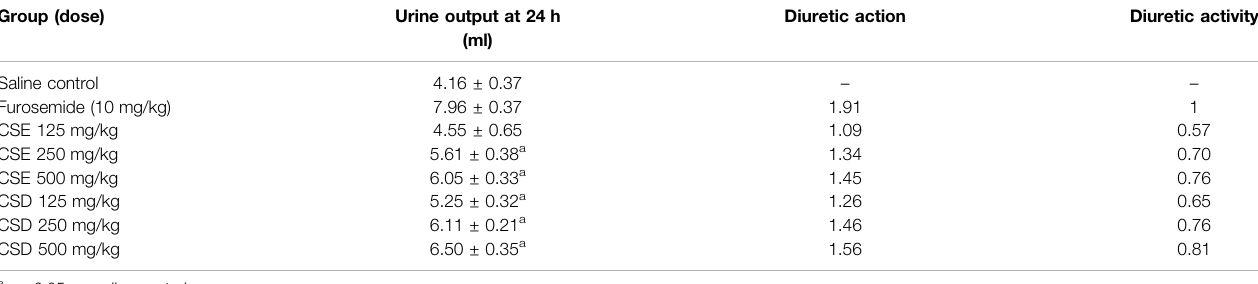
TABLE 4| Parametersofthediureticeffectinsaline-loaded Crl:WI ratstreatedwithcherry stems extract (CSE)and cherrystems decoction (CSD).Values ofurineoutputare expressed as Mean ± SD ( n (cid:1) 6). Group (dose)